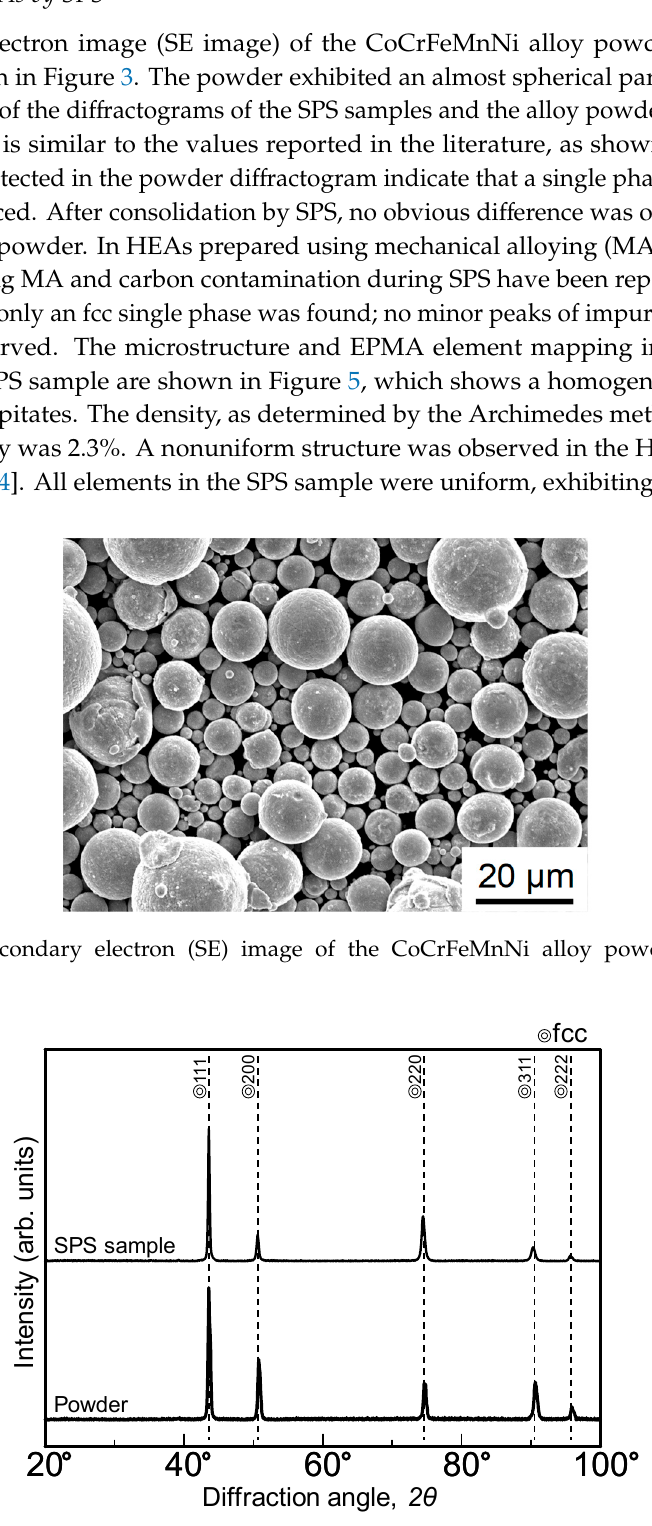
Figure 4. XRD patterns of gas-atomized high-entropy alloy (HEA) powder and the spark plasma sintering (SPS) sample sintered for 10 min at 1173 K.